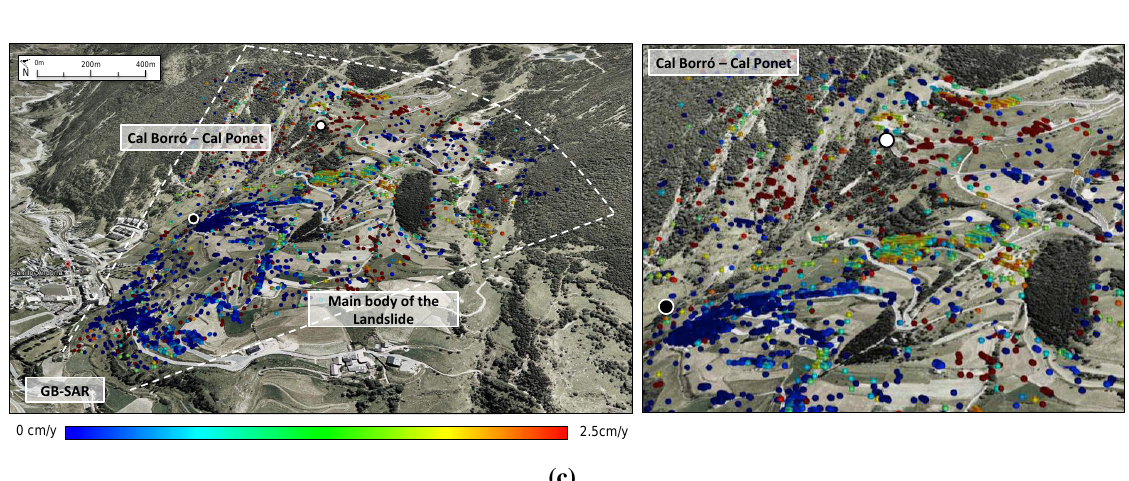
Figure 13. Geocoded down-slope linear displacement corresponding to El Forn de Canillo using ( a ) the TSC, ( b ) the coherence stability and ( c ) the D dataset. The black spot indicates the location of the seed employed during the integration step. The white spot indicates the location of the inclinometer S10, which will be employed as ground-truth to validate the